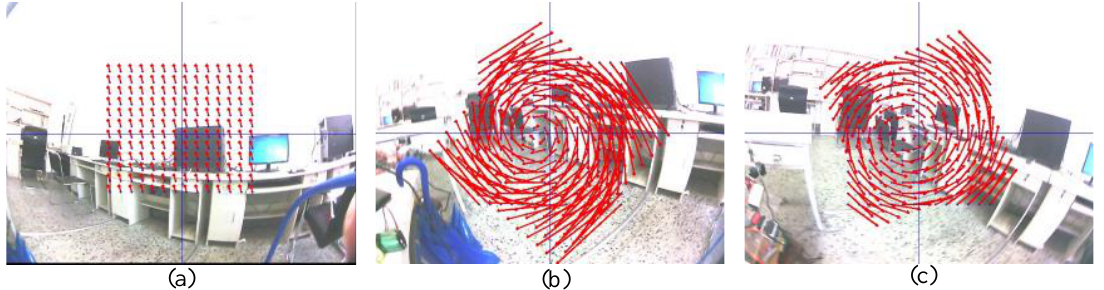
Figure 5. Motion vector with different rotational rates ( a ) ω cam z = − 1.8 rad/s, ( b ) ω cam z = 6.58 rad/s and ( c ) ω cam z = − 2.27 rad/s.